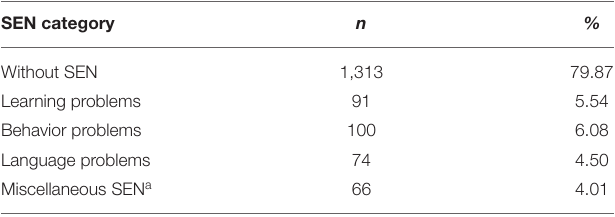
TABLE 3 | Absolute numbers and percentage of aggregated SEN